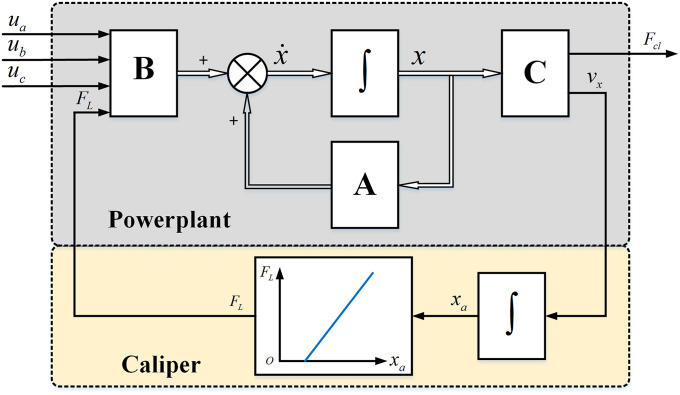
EMB system model.